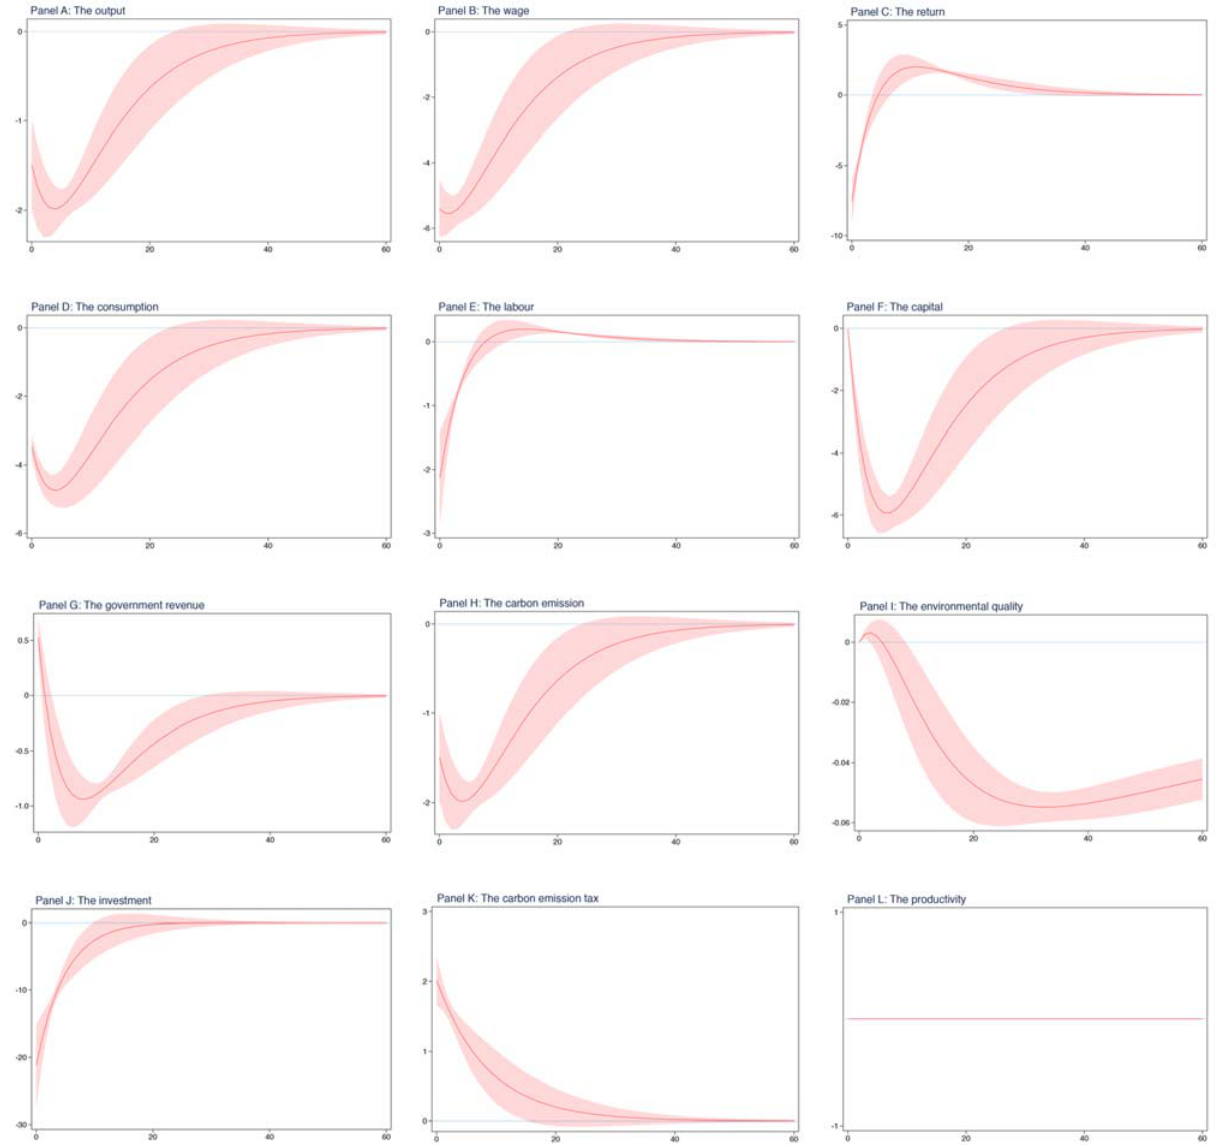
Figure 3. The impulse responses from maximum likelihood estimation.